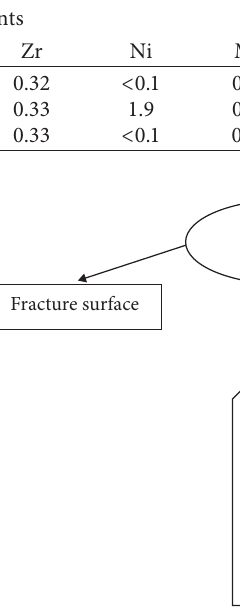
Table 1: Chemical composition of the alloys investigated in this study. Chemical analysis (wt.%)